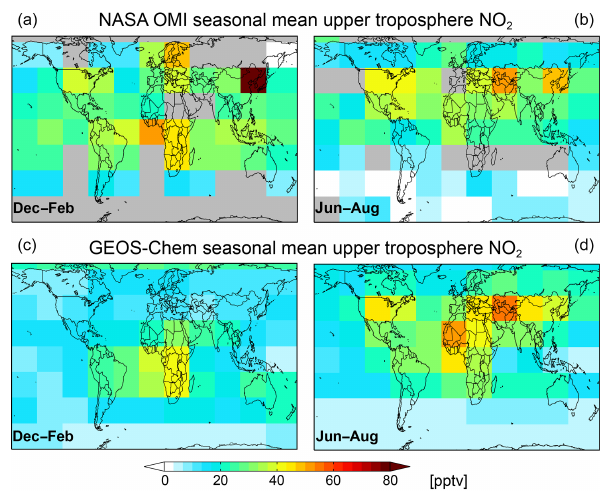
Figure 5. Observed and modeled upper troposphere NO 2 . The figure shows NASA OMI seasonal mean UT NO 2 for 2005– 2007 (a, b) and corresponding GEOS-Chem model values (c, d) . The model is sampled at 280–450hPa during the satellite overpass (12:00–15:00LT) and filtered for stratospheric influence. Data are at 20 ◦ × 32 ◦ horizontal resolution for December–February (a, c) and June–August (b, d) . Grey grid squares in the top panels indicate no OMI